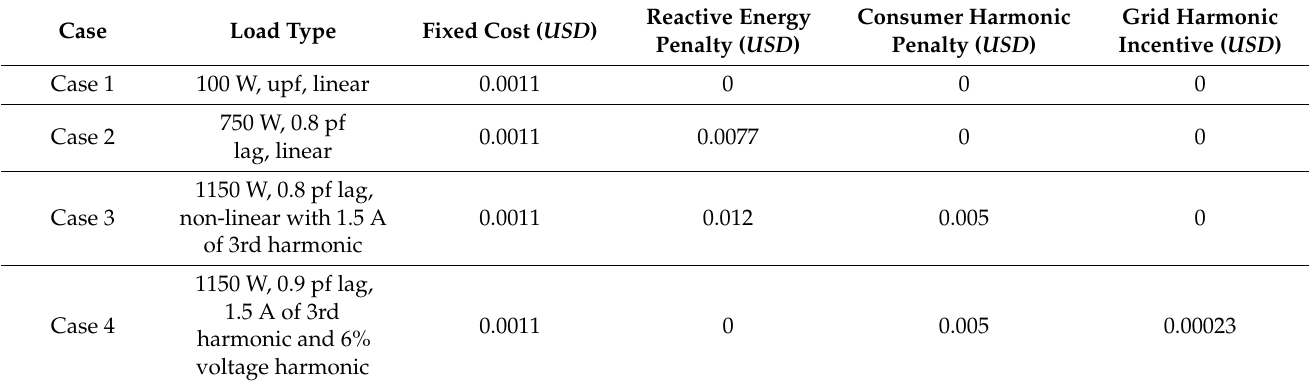
Table 3. Penalties for different